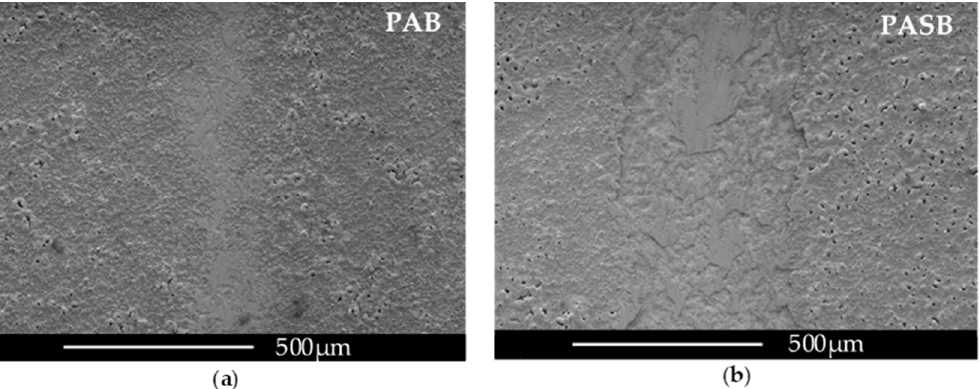
Figure 12. Micrograph of a wear track from a rotating Al 2 O 3 ball with a diameter of 6 mm after passing 200 m at a load of 2 N for a PAB sample ( a ), and PASB sample ( b ) .